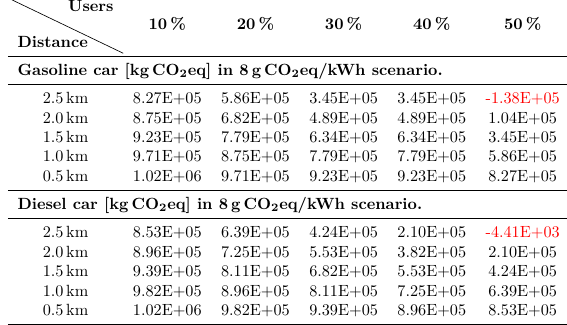
Table 3. In the table, the results are based on the refurbishment assumptions after 30 years presented. whole (60 years)